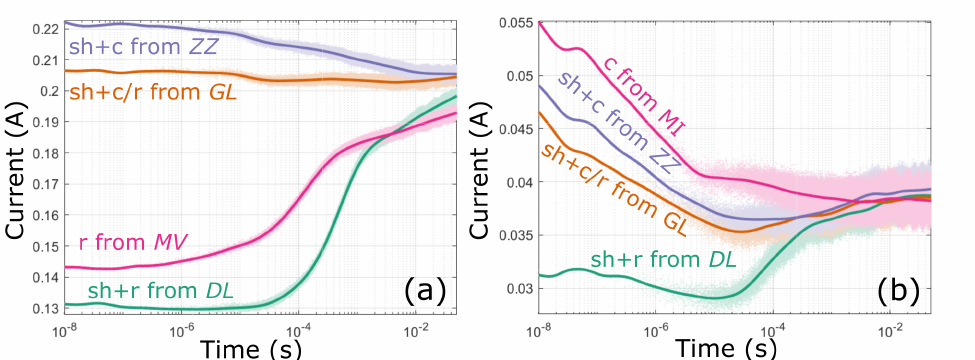
Figure 9. Time-domain current transients from ZZ , GL , DL to ( a ) MI and ( b ) MV points for device A at T c = 40 ◦ C. Lighter shades of color identify acquired points, while solid lines are smoothed versions of the current